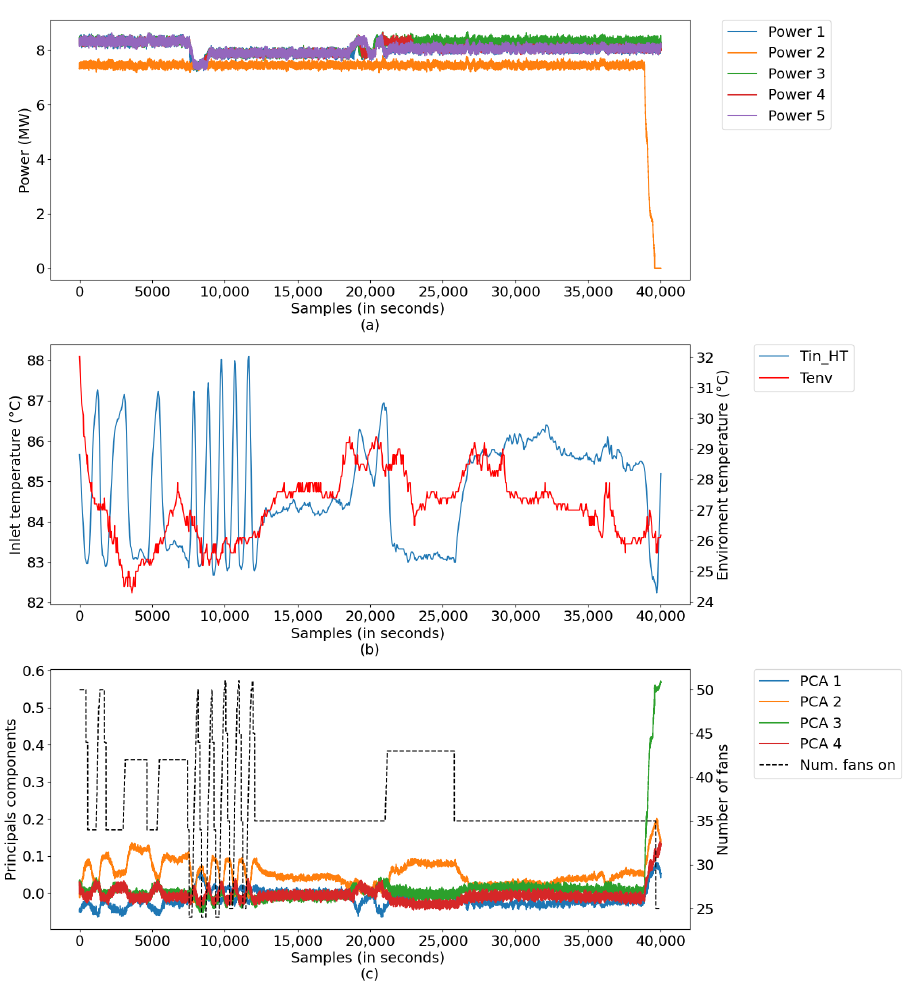
Figure 20. Process inputs: ( a ) powers of DG’s; ( b ) T in _ HT and environmental temp , and ( c ) reduced inputs and NumFanOn .